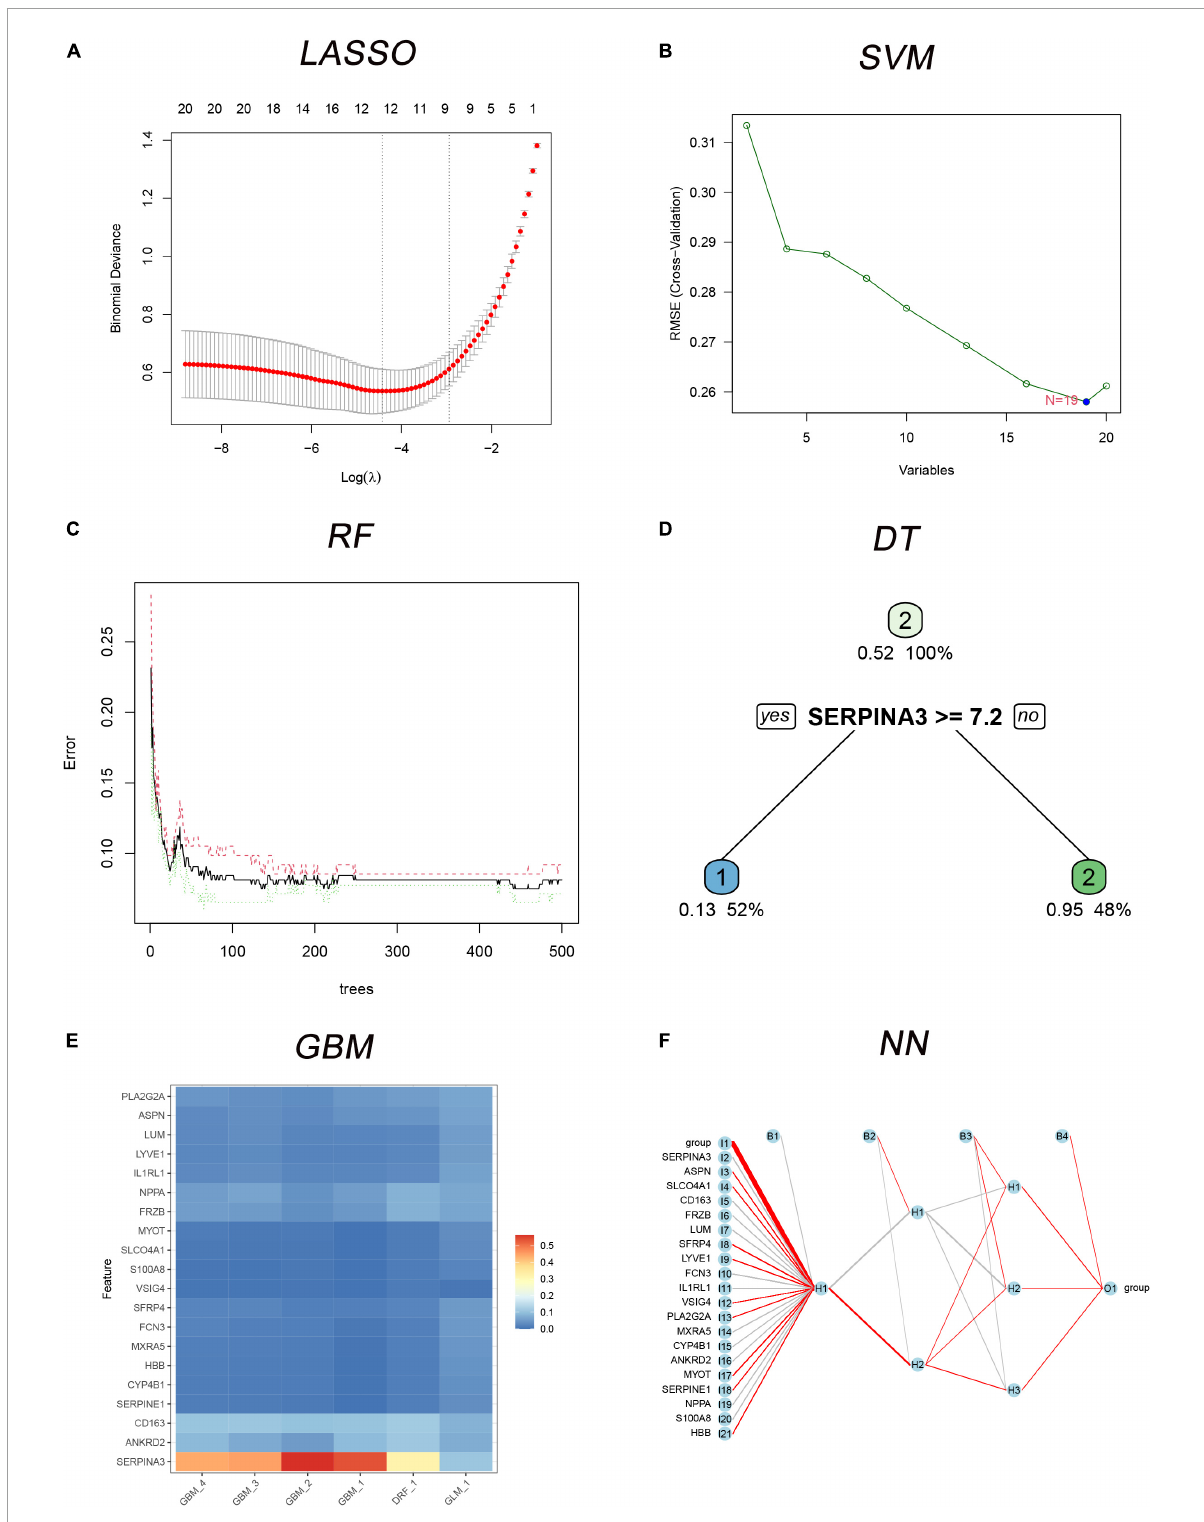
FIGURE4 The six MLs classification models built with 20 differently expressed genes (DEGs). (A) Least absolute shrinkage and selection operator (LASSO) for 9 candidate genes; (B) support vector machine (SVM) for 19 candidates DEGs; (C) the error rate of the random forest (RF) classification model with increasing trees; (D) the decision tree (DT) for classification of control and dilated cardiomyopathy (DCM) individuals; (E) multiple gradient boosting machine (GBM) classification models of control and DCM individuals; (F) neural network (NN) for classification of control and DCM